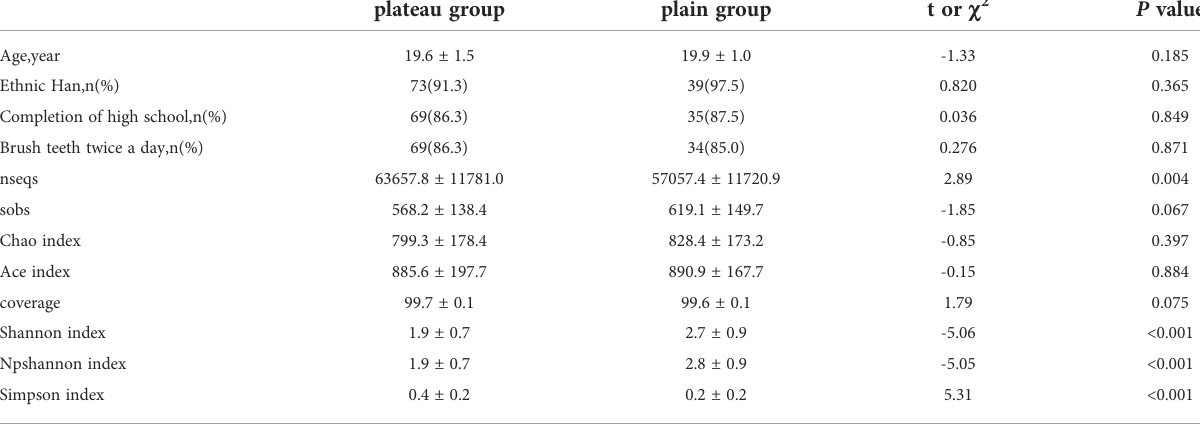
TABLE 1 Comparison of general characteristics and Alpha diversity between the two groups. plateau